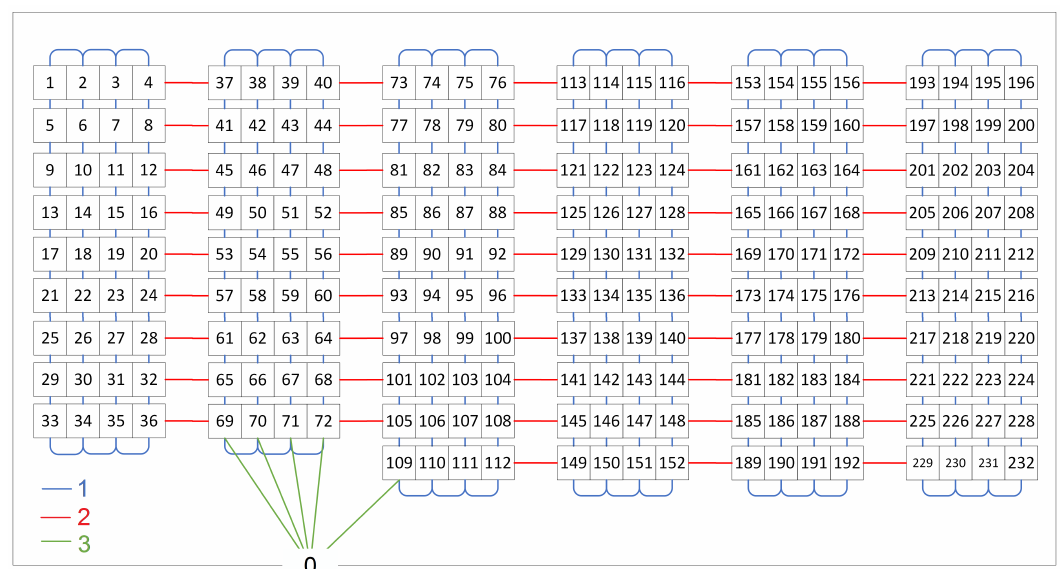
Figure 7. A sample warehouse structure (floor plan) of the warehouse w2 used in the experiments. Each numbered cell represents one product location. Blue lines show the distance of 1 unit, red lines of 2 units and green lines of 3 units.